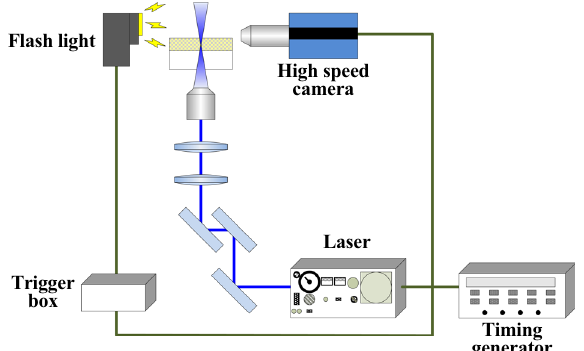
Figure 6. Experimental shadowgraphy setup used to monitor QD-CPNW growth using a high-speed camera. QD-CPNW was generated from the polymer film surface by laser irradiation through the borosilicate glass substrate. The high-speed video camera recorded the shape of the QD-CPNW as a shadowgraphy image. A timing generator was used for setting the time delays for the QD-CPNW generation laser, the flashlight, and high-speed video camera